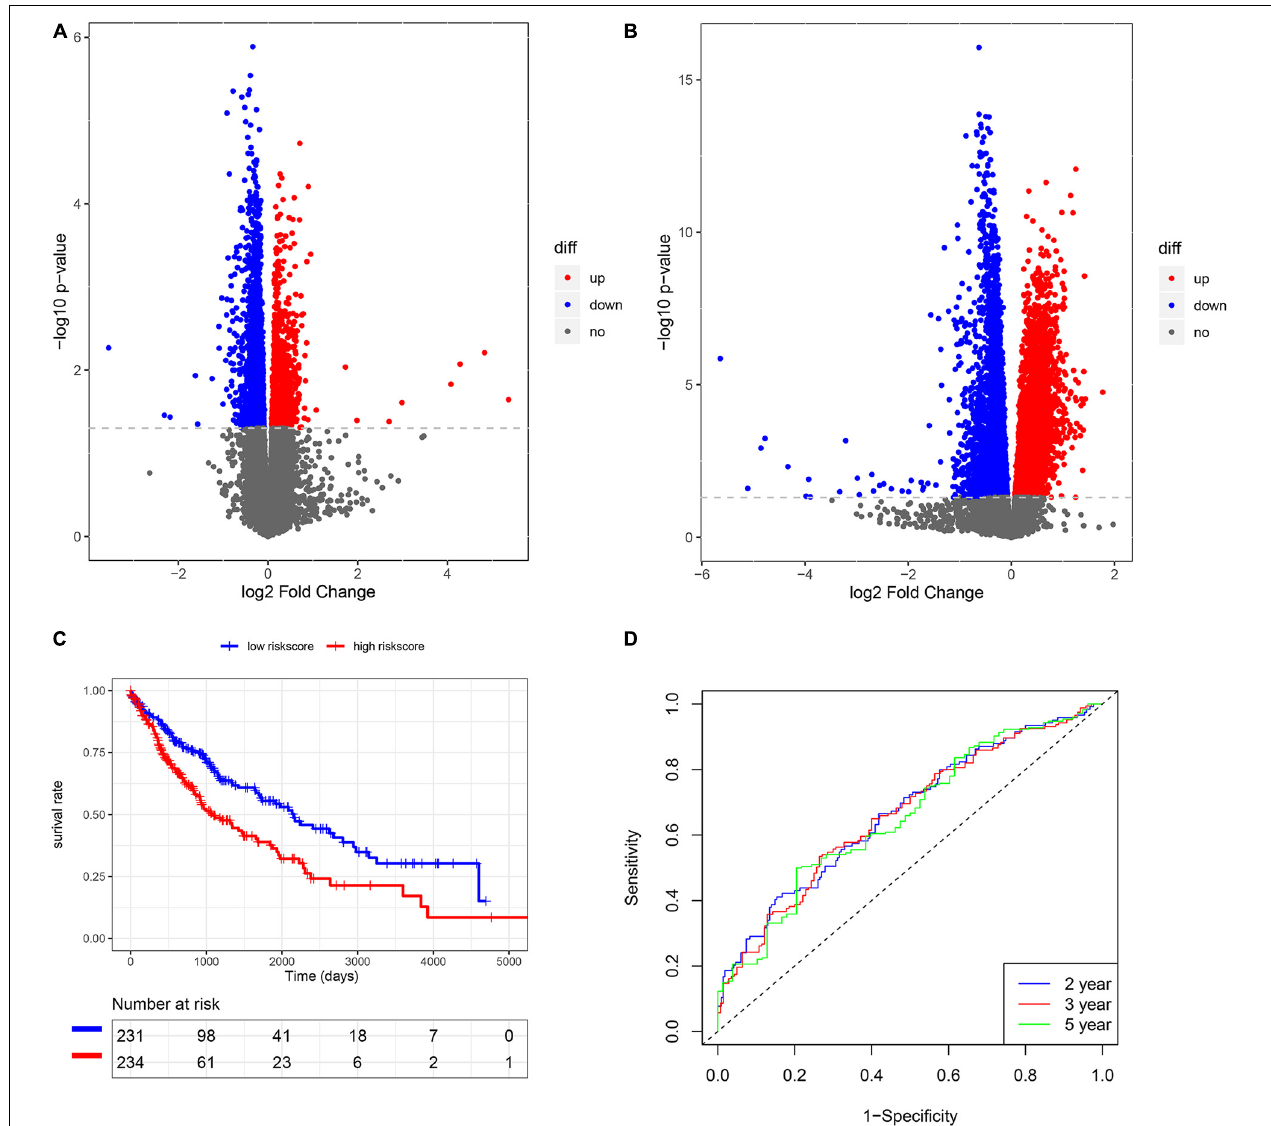
FIGURE 2 | The construction of risk score model in LUSC. (A) The volcano plot of smoking-related genes. (B) The volcano plot of HRD-related genes. (C) K-M analysis of risk score model. (D) Survival ROC of risk score